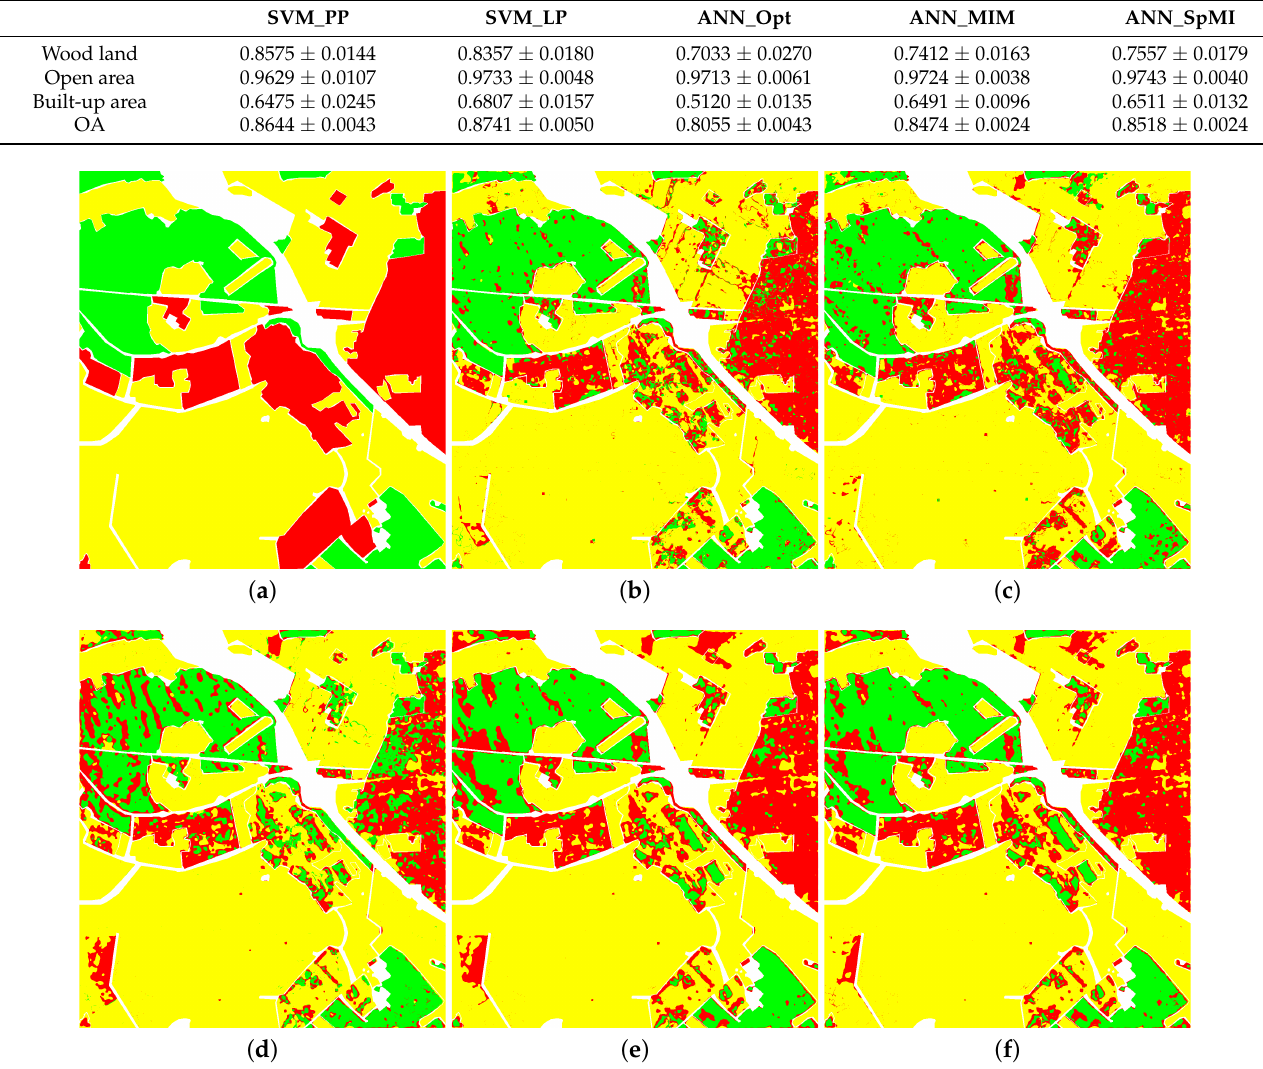
Table 15. The objective indicators of three ANN-based classifiers and two SVM classifiers on different forms of parameters of Touzi decomposition for the Oberpfaffenhofen image.